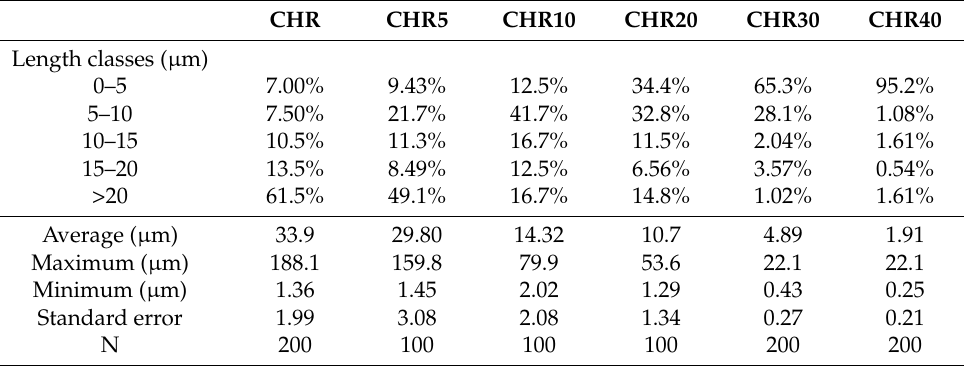
Table 2. Fraction of chrysotile fibres comprised in a given interval of fibre length after each milling treatment and main statistical parameters of fibre lengths. Raw chrysotile (CHR); chrysotile after 5 min of milling (CHR5); chrysotile after 10 min of milling (CHR10); chrysotile after 20 min milling (CHR20); chrysotile after 30 min of milling (CHR30); chrysotile after 40 min of milling (CHR40). Number of fibres